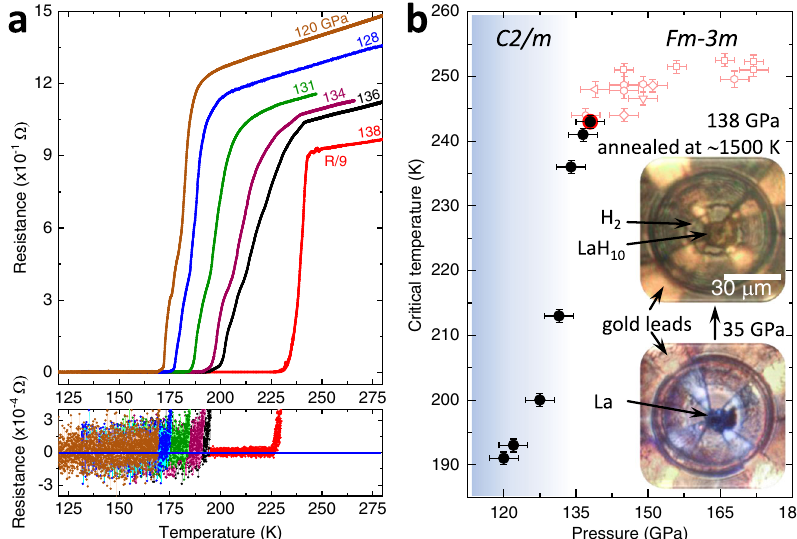
Fig. 2 The superconducting transitions in LaH 10 . a The electrical resistance in LaH 10 after the synthesis under 138 GPa (red curve), after the abrupt decompression down to 120 GPa (brown curve), and upon a gradual increase in pressure from 120 to 136 GPa (blue, green, purple, and black curves). The data measured at 138 GPa on the upper panel are divided by 9 for better presentation. b Pressure dependence of T c in LaH 10 measured in the present study (black symbols) and from a prior study 3 (open red symbols). Insets: photos of the DAC loaded with a La fl ake and after the synthesis of LaH 10 through laser-assisted